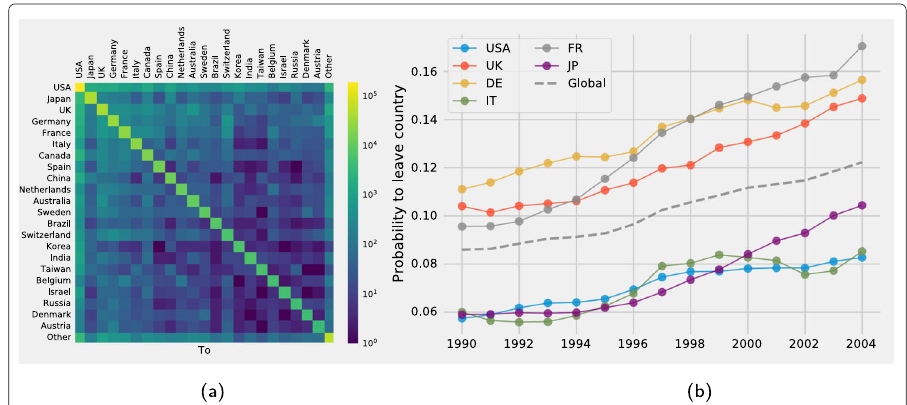
Fig. 3 a The Country to country mobility flows for the mobility network of 2004 with 5 year of buffer. On the main diagonal we find the number of all scientists who did not leave the country (i.e. the national scientist population). The rows are the source and the columns are the destination, with the color indicating the number. The countries are sorted according the size of their scientist population in the period 1999 to 2004. b Probability to leave country for selected countries and global mean (1990 to 2004). Note: the “country” is the country from which the move originates, not necessarily the nationality of the author